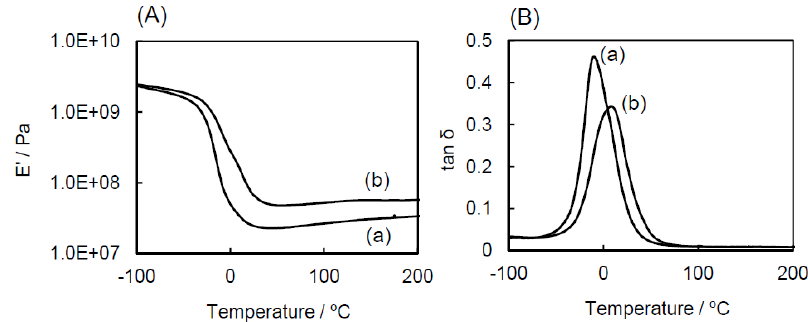
Figure 5. Dynamic viscoelasticity of ( a ) ESO homopolymer and ( b ) ESO/POSS-1